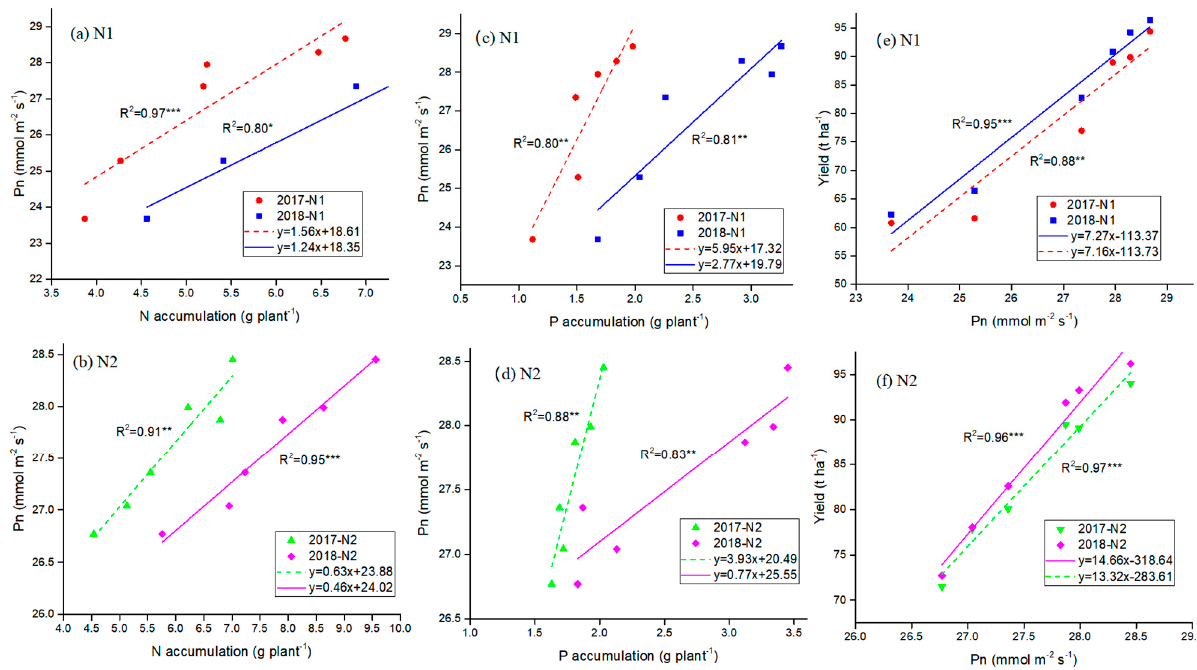
Figure 4. Relationship between total N accumulation and Pn ( a , b ), total P accumulation and Pn ( c , d ), and Pn and tomato yield ( e , f ) in 2017 and 2018. *, **, ***represents significant correlations at the p < 0.05, p < 0.01, p < 0.001 level.